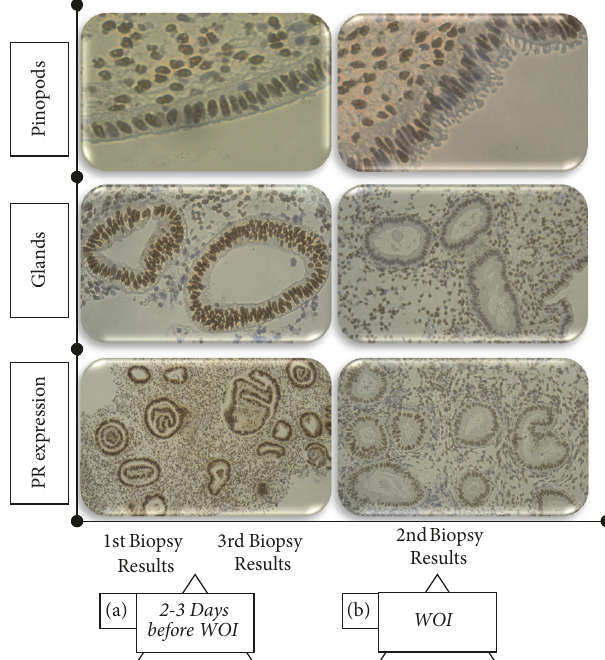
Figure 1: Endometrial cycle dating based on Noyes et al.’s criteria and immunohistochemical analysis for progesterone receptors (PR) of woman’s endometrium. Paraffin embedded sections of the endometrium before and during the window of implantation (WOI). Pinopodes on luminal epithelium were confluent; glands secretion and stromal edema were well developed during WOI (b) compared to the prereceptive phase (a). The expression of progesterone receptors in patient’s endometrium was lower during the window of implantation (b).